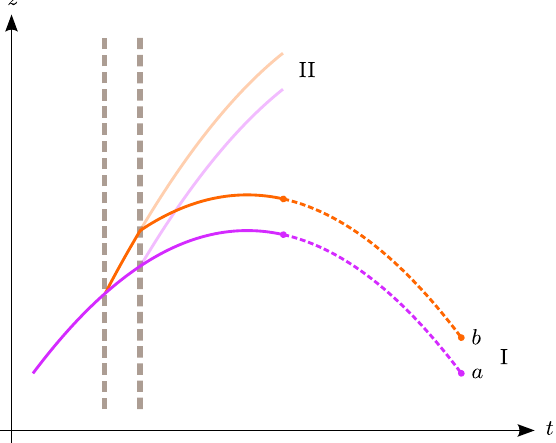
FIG. 8. Central trajectories for an open interferometer in the laboratory frame. The proper-time difference between the ex- tended wordlines as the detection time is delayed (dashed lines) increases due to the gravitational time dilation, but this is exactly compensated by the growth of the separation phase as explained in Appendix C